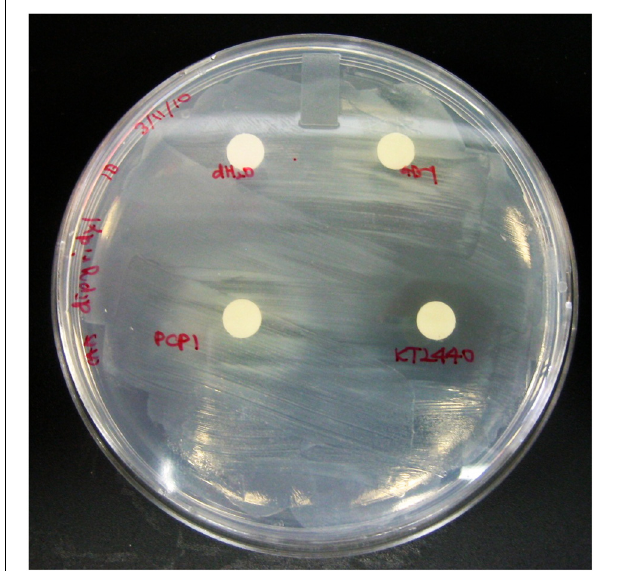
FIGURE 2 | The P. putida GB-1 NRPS mutant KG163, which does not produce PVD, was overlayed on CAA plates supplemented with 100 µ M dipyridyl, an agent that strongly complexes Fe. 20 μ l of PVD solutions from P. putida GB-1, P. putida KT2440, and Pseudomonas sp. PCP1 or MilliQ water were put on filter disks to determine the ability of exogenous PVDs to release Fe from it dipyridyl complex and to support the growth (observed as visual turbidity) of a P. putida GB-1 mutant that lacks the ability to produce PVD.